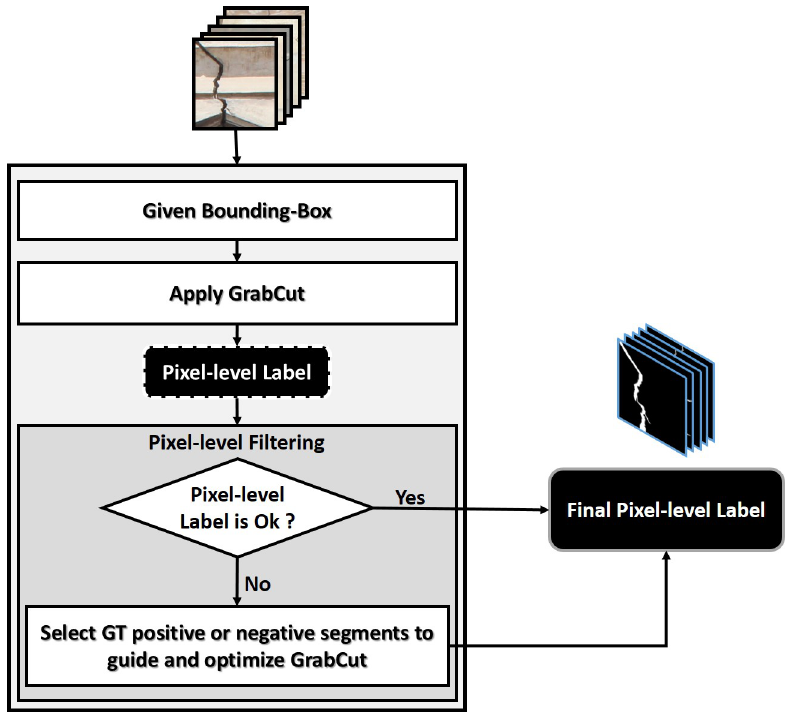
Figure 4. Illustration of semi-supervised GrabCut pixel-level map generation. GrabCut is an iterative segmentation method, which is an extension of the Graphcut method. Gaussian mixture models (GMMs) are used for color images instead of the model for monochrome images. GMMs are utilized to learn the color distributions of the background and foreground by assigning each pixel a probability to belong to a group of other pixels [22,23]. Given a color image I , let us consider the array z = ( z 1 , ..., z n , ..., z N ) of N pixels, where z i = ( R i , G i , B i ) , i ∈ [ 1, .. ., N ] in the RGB space. The segmentation of the image is presented as an array of opacity values α = ( α 1 , ..., α N ) at each pixel with α n ∈ 0, 1, with 0 and 1 for background and foreground, respectively. Two GMMs for the background and the foreground are taken to be the full-covariance Gaussian mixture with K components. In the optimization framework, an extra vector k = k 1 , ..., k n , ..., k N is introduced, with k n ∈ 1, ... K , assigning each pixel a unique GMM component either from the foreground or the background model according to α n to easily deal with the GMM [22,23]. The Gibbs energy function E defined by GrabCut for segmentation, such that its minimum value should agree with a good segmentation, and it is computed as